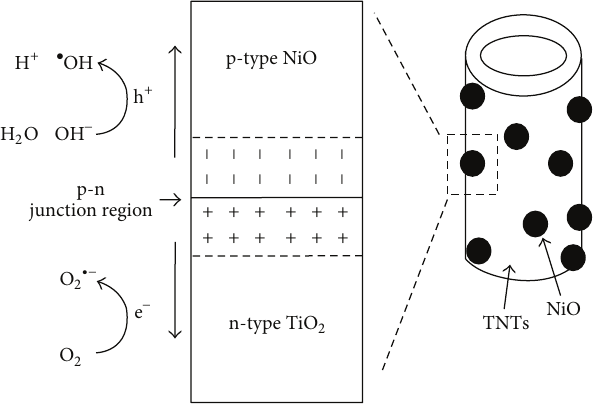
Figure 8: Schematic diagram of electron transport in NiO/TNTs photocatalyst under solar light